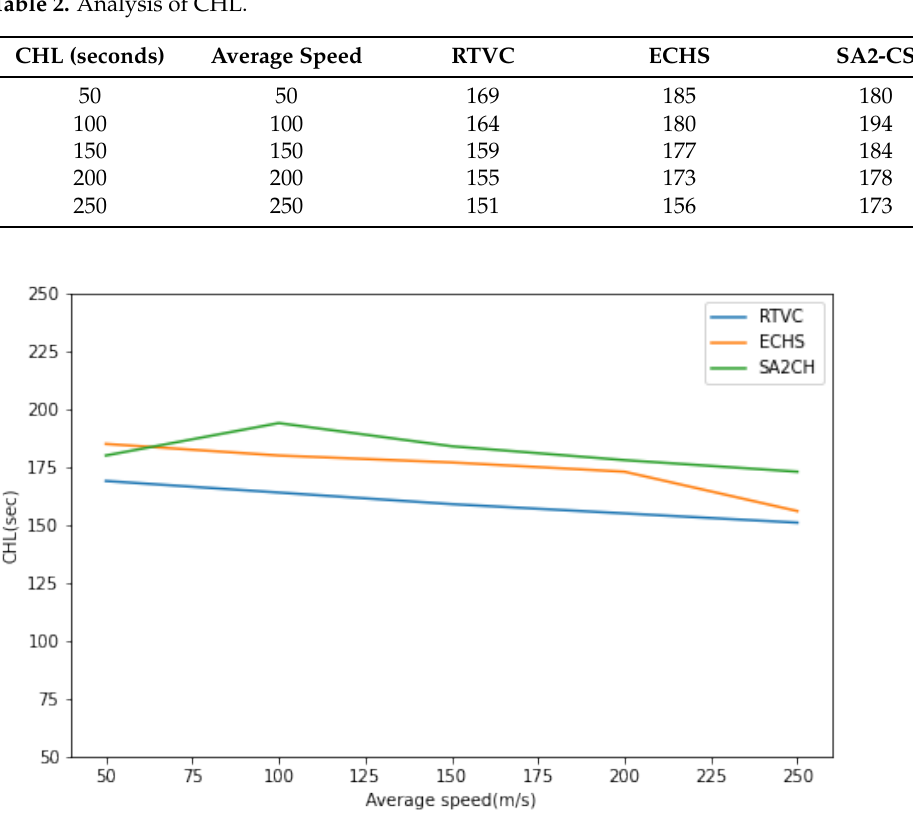
Figure 7. Comparative graph of CHL between the existing and proposed